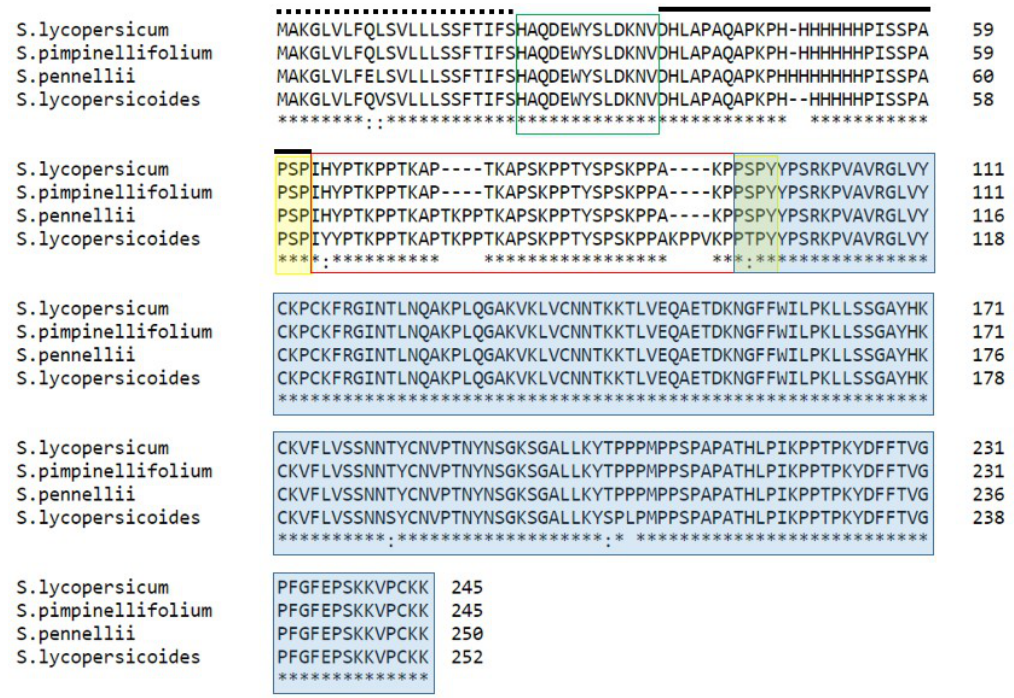
Figure 7. Multiple alignments of HD-AGP protein sequences from Solanum lycopersicum ( Sl PRP1), S. pimpinellifolium ( Spp PRP1), S. pennellii ( Sp PRP1), and S. lycopersicoides ( Sly PRP1). The signal peptide sequence is shown with a dotted line above; the two hypervariable domains, HVI and HV2, are boxed in green and red, respectively; a black line lies over the histidine-rich domain; the highly conserved PAC / ole-1 domain is highlighted in blue.